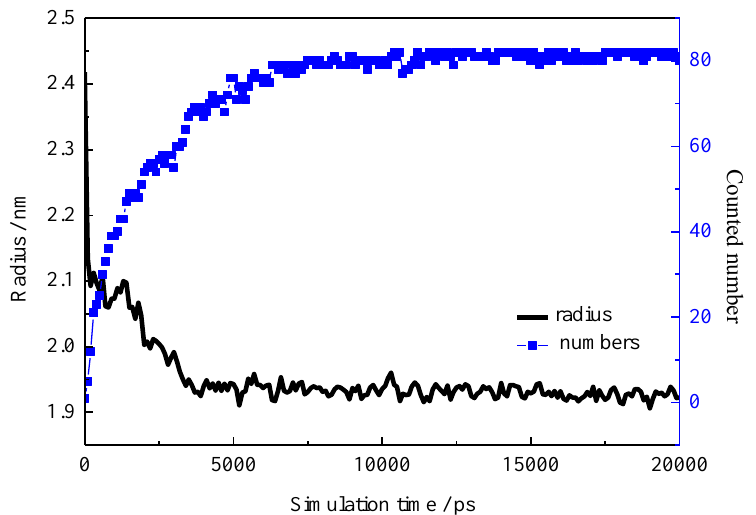
Figure 2. Radius of the rod-like micelle and solubilized numbers of PTA − in the micelle plotted as a function of simulation time.